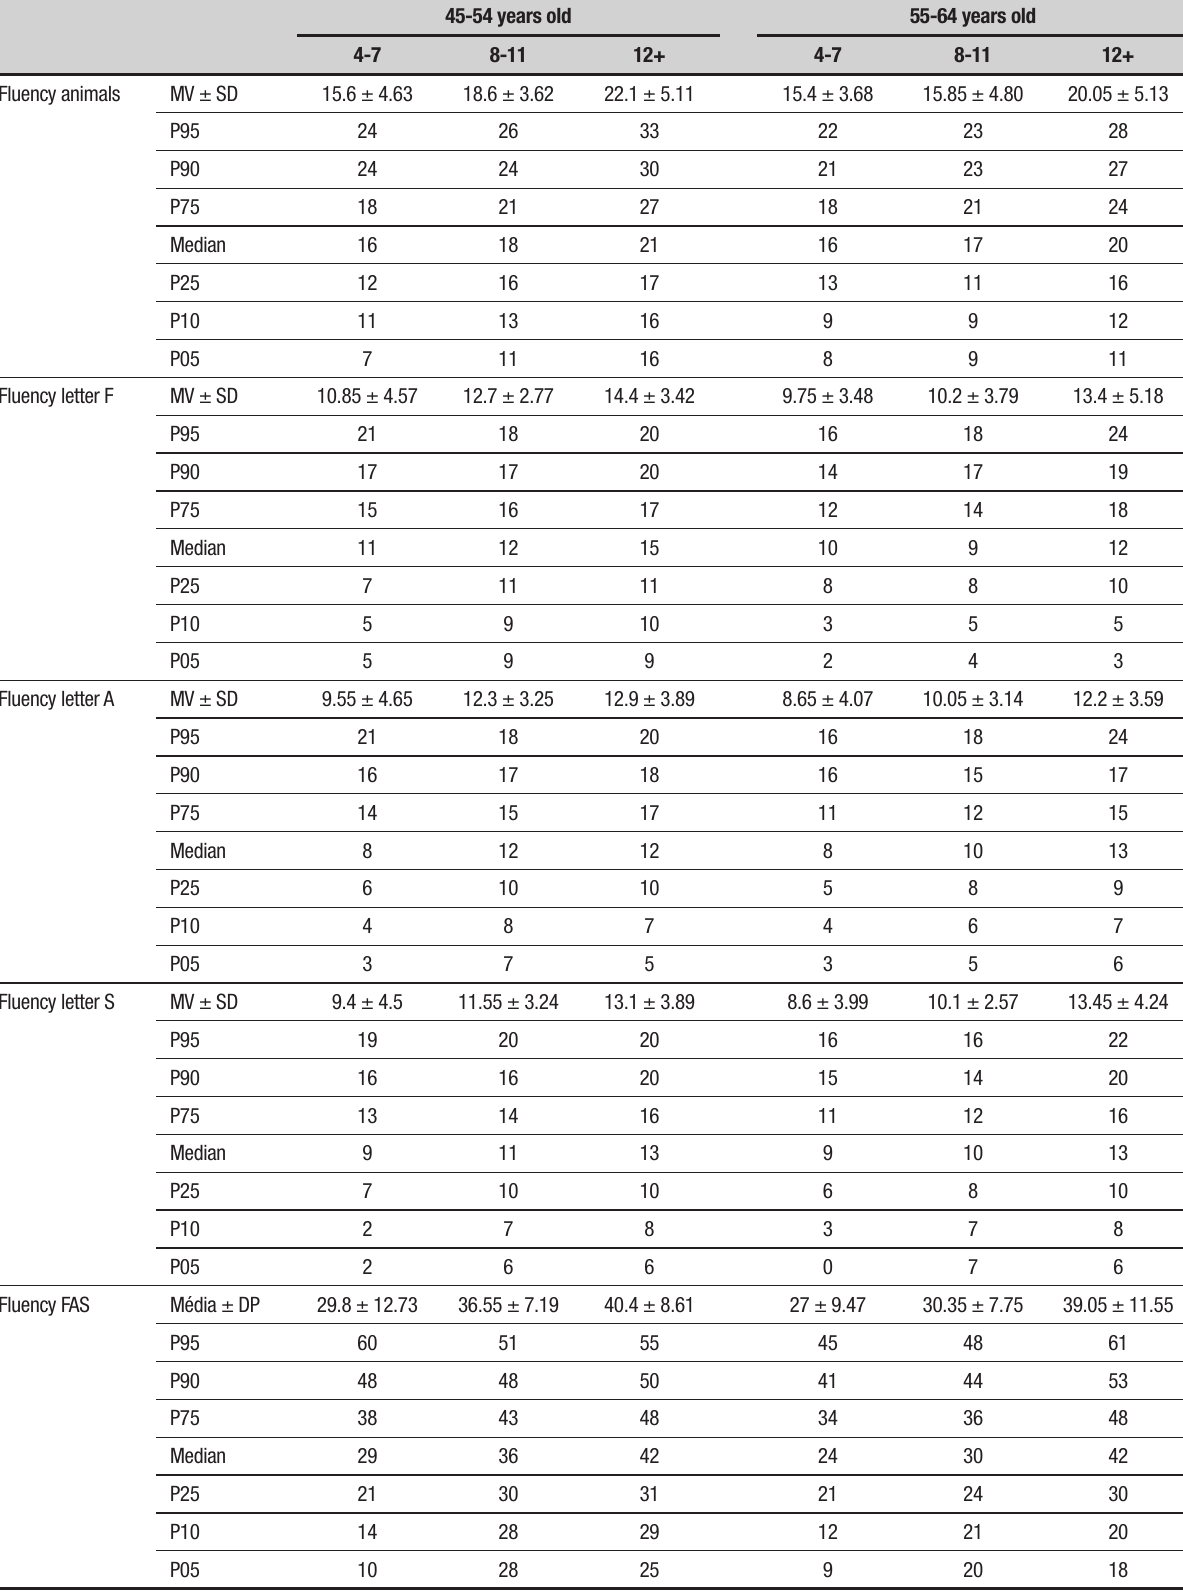
Table 3. Normative data for fluency tests (animals and